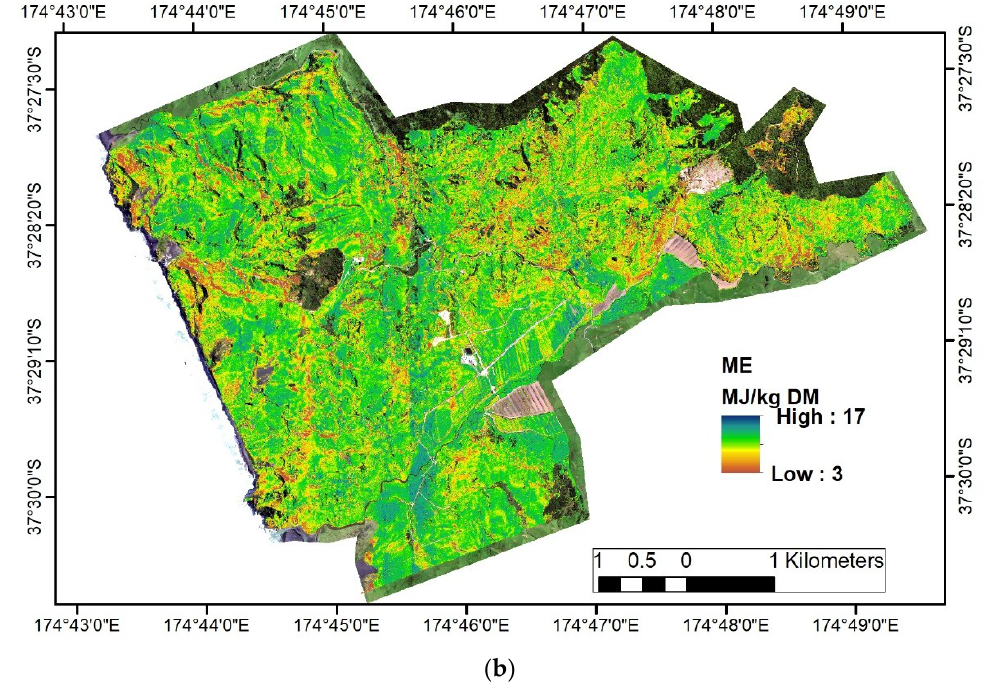
Figure 6. Pasture quality spatial maps produced from fusion of hyperspectral, topographic, and soil data using recursive feature selection–random forest regression ( a ) crude protein (CP) concentration map ( b ) metabolizable energy map. Predictions are only shown for pasture areas.